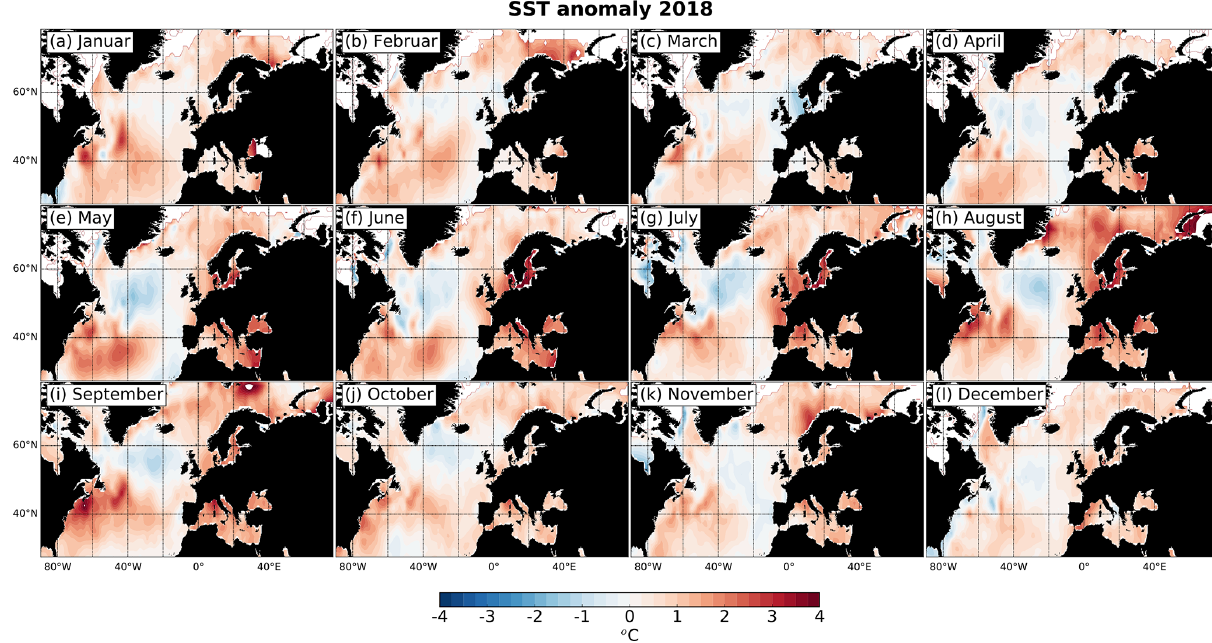
Figure A1. Monthly sea surface temperature (SST) anomalies throughout 2018 relative to the reference period (1971–2000).